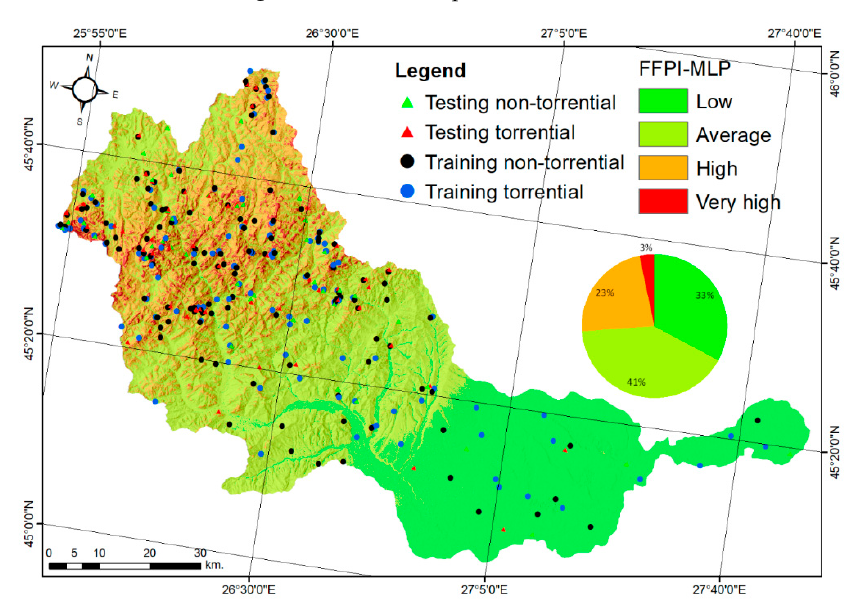
Figure 10. FFPI–MLP spatial distribution.